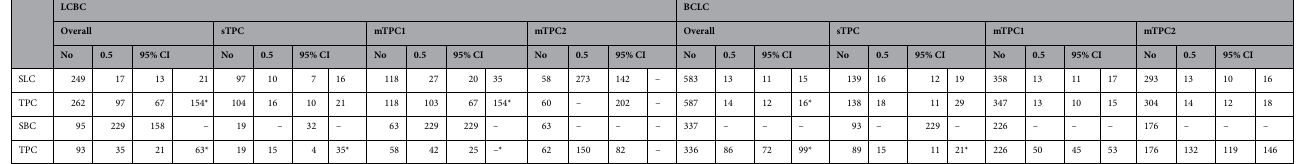
specific death relative to the matched patients were observed in mTPC1 group (H.R 0.28, 95% CI 0.19–0.41; SHR 0.33, 95% CI 0.23–0.47.). For BCLC and matched single lung cancer, median overall survival times were 14 and 13 months, respectively (Table 2); incidence of all-cause and cancer-specific death was generally not different from each other (H.R 0.92, 95% CI 0.80–1.05; SHR 0.87, 95% CI 0.76–1.00). Meanwhile, overall survival time of LCBC and BCLC was generally shorter than that of matched single bladder cancer, and incidence of all-cause and cancer-specific death in the two primaries was higher than the matched ones either (Tables s2–s9). Median overall survival times of LCPC and single lung cancer involved in the cohort form PSM analysis were 116 and 16 months, respectively (Table 3); incidence of all-cause and cancer-specific death in LCPC was lower than that in corresponding lung cancer (Coef. − 1.31, 95% CI − 1.46 to 1.15; SHR 0.40, 95% CI 0.35–0.47). Further analysis suggested that prognosis of sTPC group was not statically different from that of matched single